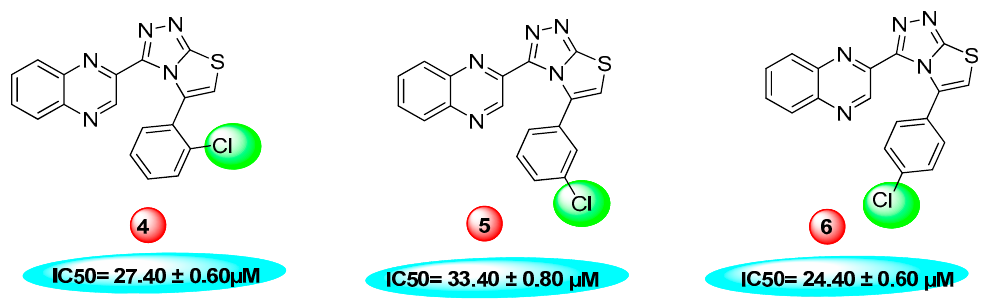
Figure 4. Activity of chlorine substitutions at different positions.